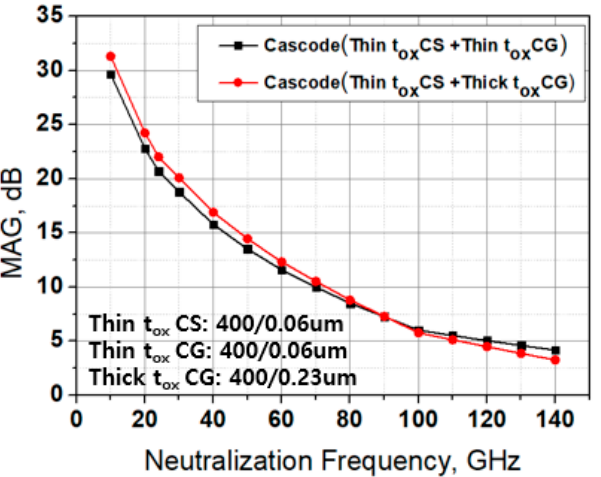
Figure 2. Calculated MAG using extracted equivalent circuit parameters according to the neutralization frequency (thin-oxide FET CS + thin/thick-oxide FET CG).